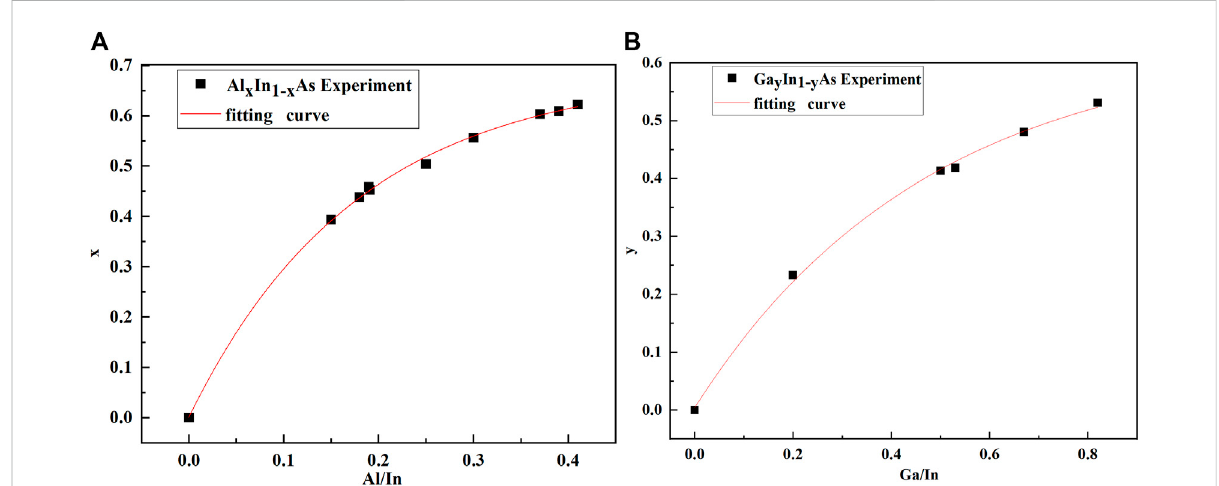
FIGURE 1 (A) FittingcurveoftheAlcompositionsinAl ratios.